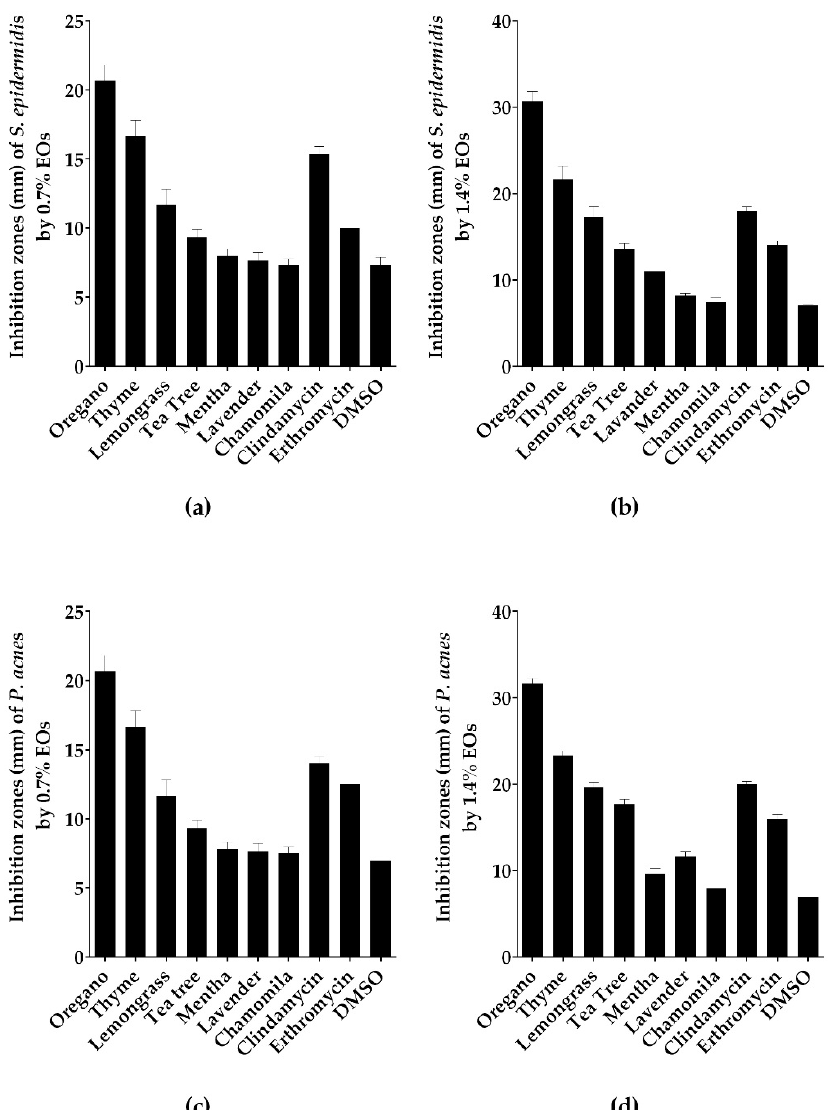
Figure 1. Oregano EO exhibited the largest inhibition zone among the tested oils. Antibacterial activity of the screened EOs using agar disc diffusion method against ( a ) S. epidermidis with EOs at concentration of 0.7%; ( b ) S. epidermidis with EOs at concentration of 1.4%; ( c ) P. acnes with EOs at concentration of 0.7%; ( d ) P. acnes with EOs at concentration of 1.4%. Data is represented as means of inhibition zones (mm) ± SD. Controls used were clindamycin and erythromycin as positive control, while DMSO as negative control.